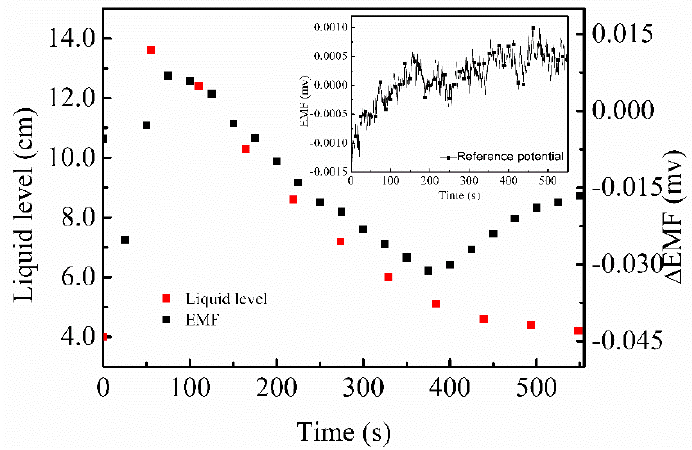
Figure 6. Evolution of liquid level and EMF signals during water tapping.